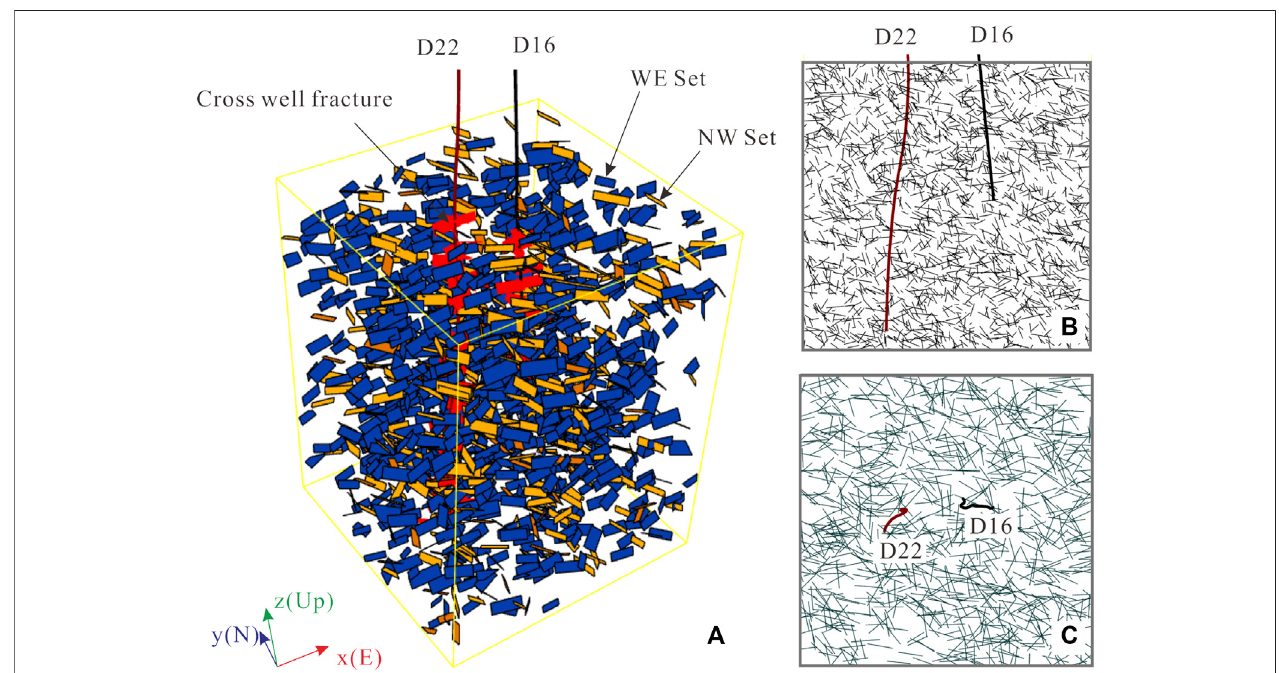
FIGURE 5 | (A) Three-dimensional DFN fracture modeling results the red pieces represent the logged fractures in well D22 and the black line represents well D16. Only 1% of the generated fractures are displayed. Blue denotes the EW set, and orange denotes the NW set; (B) EW vertical pro fi le fracture tracemap through D22 and D16; (C) Horizontal fracture trace map at the depth of 3000 m.